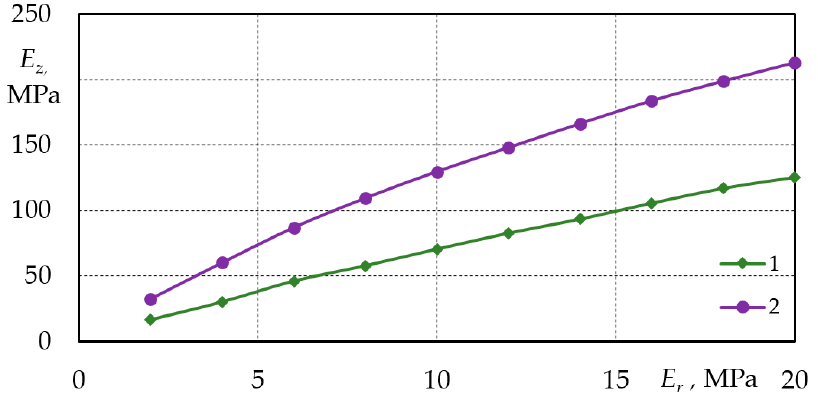
Figure 12. Tire band elastic modulus in X and Z directions: 1—model a (8 layers) in X direction, 2— Figure 13. Dependence of the tire band modulus of elasticity on the modulus of elasticity of rubber ( σ z = 0.2 MPa): 1—7 layers and 2—8 layers.